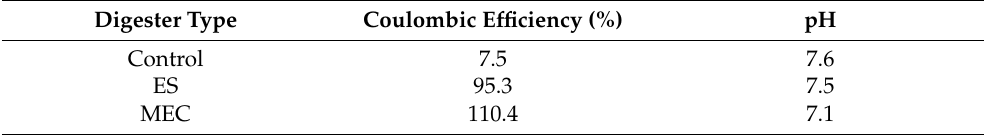
Table 3. Coulombic efficiency and pH with respect to digester